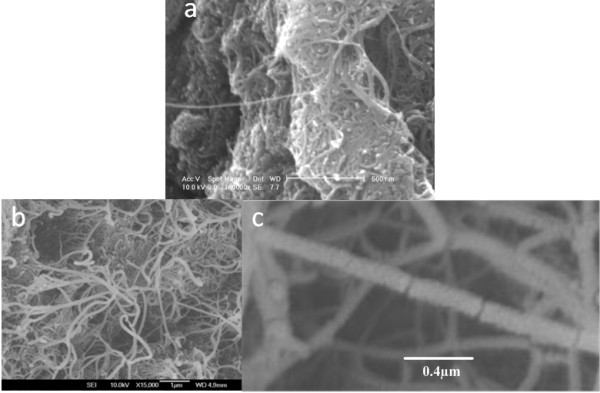
SEM image of the nanotubes used in this experiment. (a) Before and (b,c) after manual grinding.